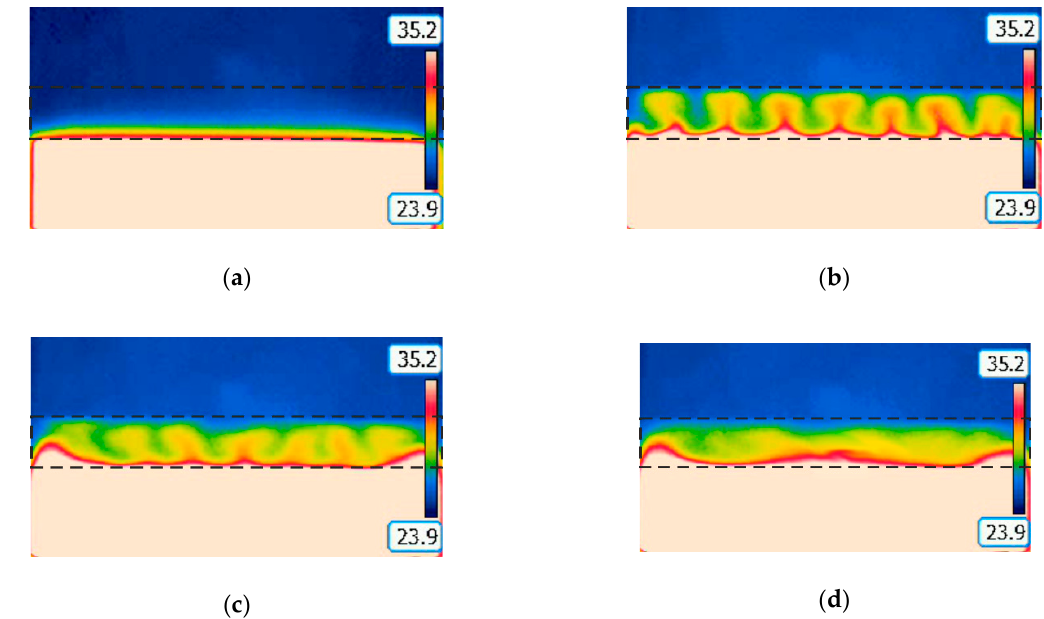
Figure 4. The infrared image of temperature distribution in a cell with a magnetic nanofluid: ( a ) uniform temperature distribution (in horizontal direction) 1 min after the start of heating; ( b ) the pattern of developed thermal convection 2.5 min after the start of heating in the absence of magnetic field; ( c ) the pattern 5 s after turning on the magnetic field while heating continues; ( d ) the pattern 12 s after turning on the magnetic field while heating continues. The magnetic field is applied horizontally in the figure plane; magnetic field strength is H = 135 kA/m. The area of the magnetic nanofluid is indicated by a dashed line.